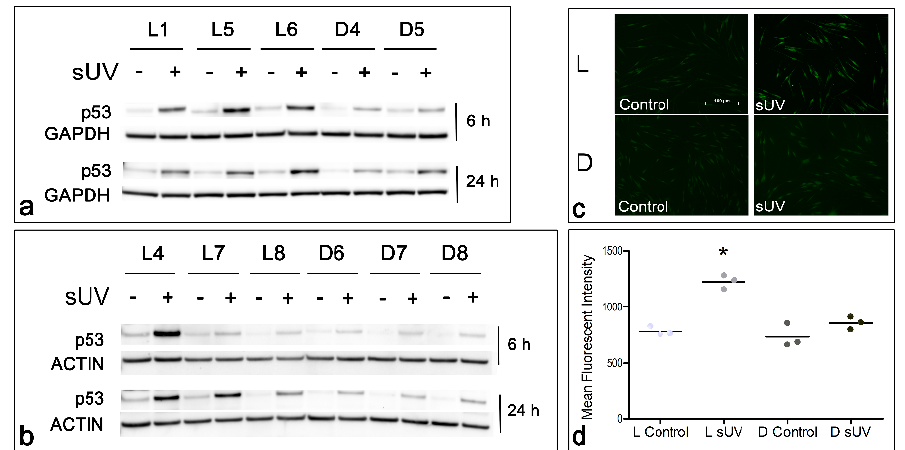
Figure 6. Comparison of the solar UV − induced increase in p53 and lipid peroxidation in L versus D melanocyte cultures. ( a , b ) Represent Western blot analysis of p53 in a total of 6 L and 5 D cultures in two independent experiments after 6 and 24 h post-solar UV irradiation. ( c ) Depicts representative control and solar UV − irradiated L and D melanocytes that were stained for lipid peroxidation 1 h post − solar UV. ( d ) Represents a quantitative analysis of the mean fluorescence of the control and solar UV-irradiated melanocytes (a total of 3 L and 3 D cultures) that were stained for peroxidized lipids. L1, L5, L6, D3, and D4, but not D5, responded to solar UV with a statistically significant increase in lipid peroxidation ( p < 0.001). * = Statistically different from all other groups ( p <